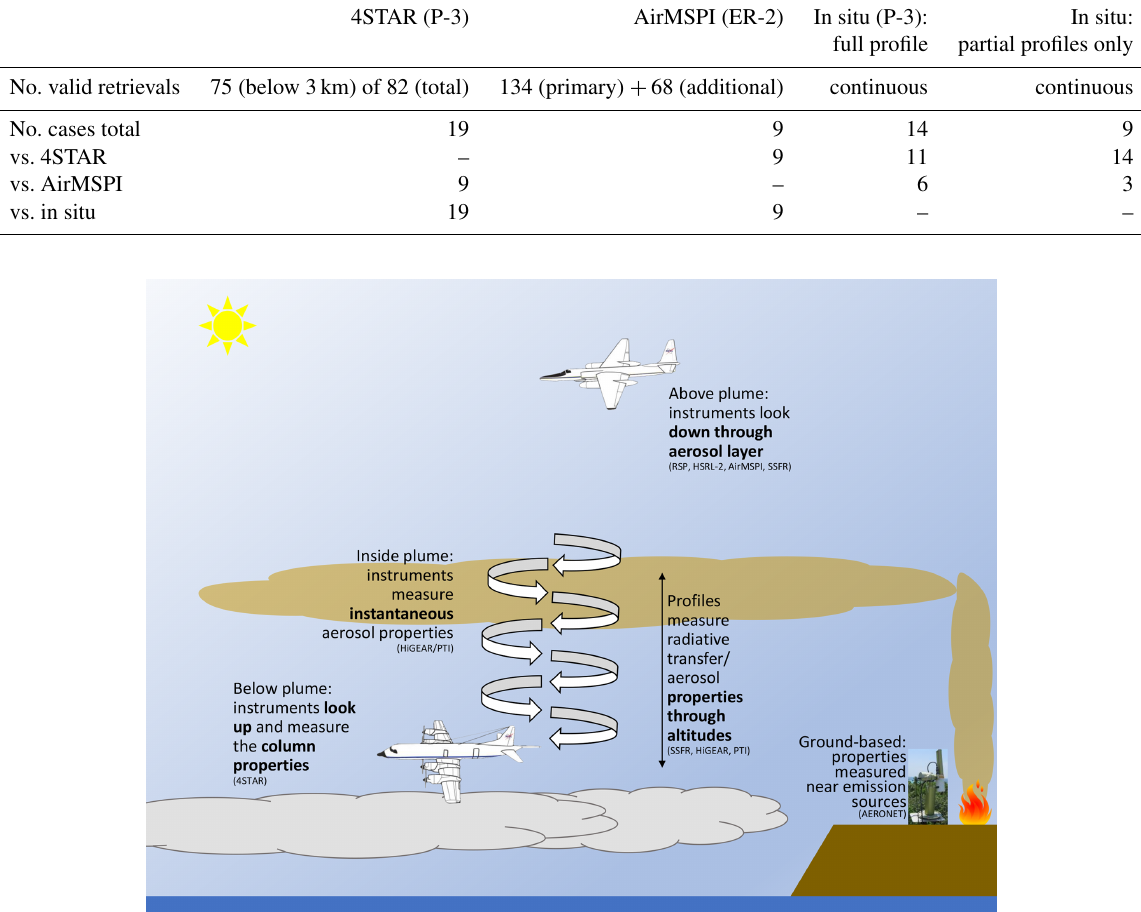
Figure 3. Schematic illustrating the different successive measurement orientations necessary for a comparison of aerosol properties using different instruments and aircraft in an aerosol-above-cloud environment. The aircraft shown are those used in ORACLES: the high-altitude (30km) ER-2 (top) and the propeller P-3B aircraft (bottom) for tropospheric sampling (approximately